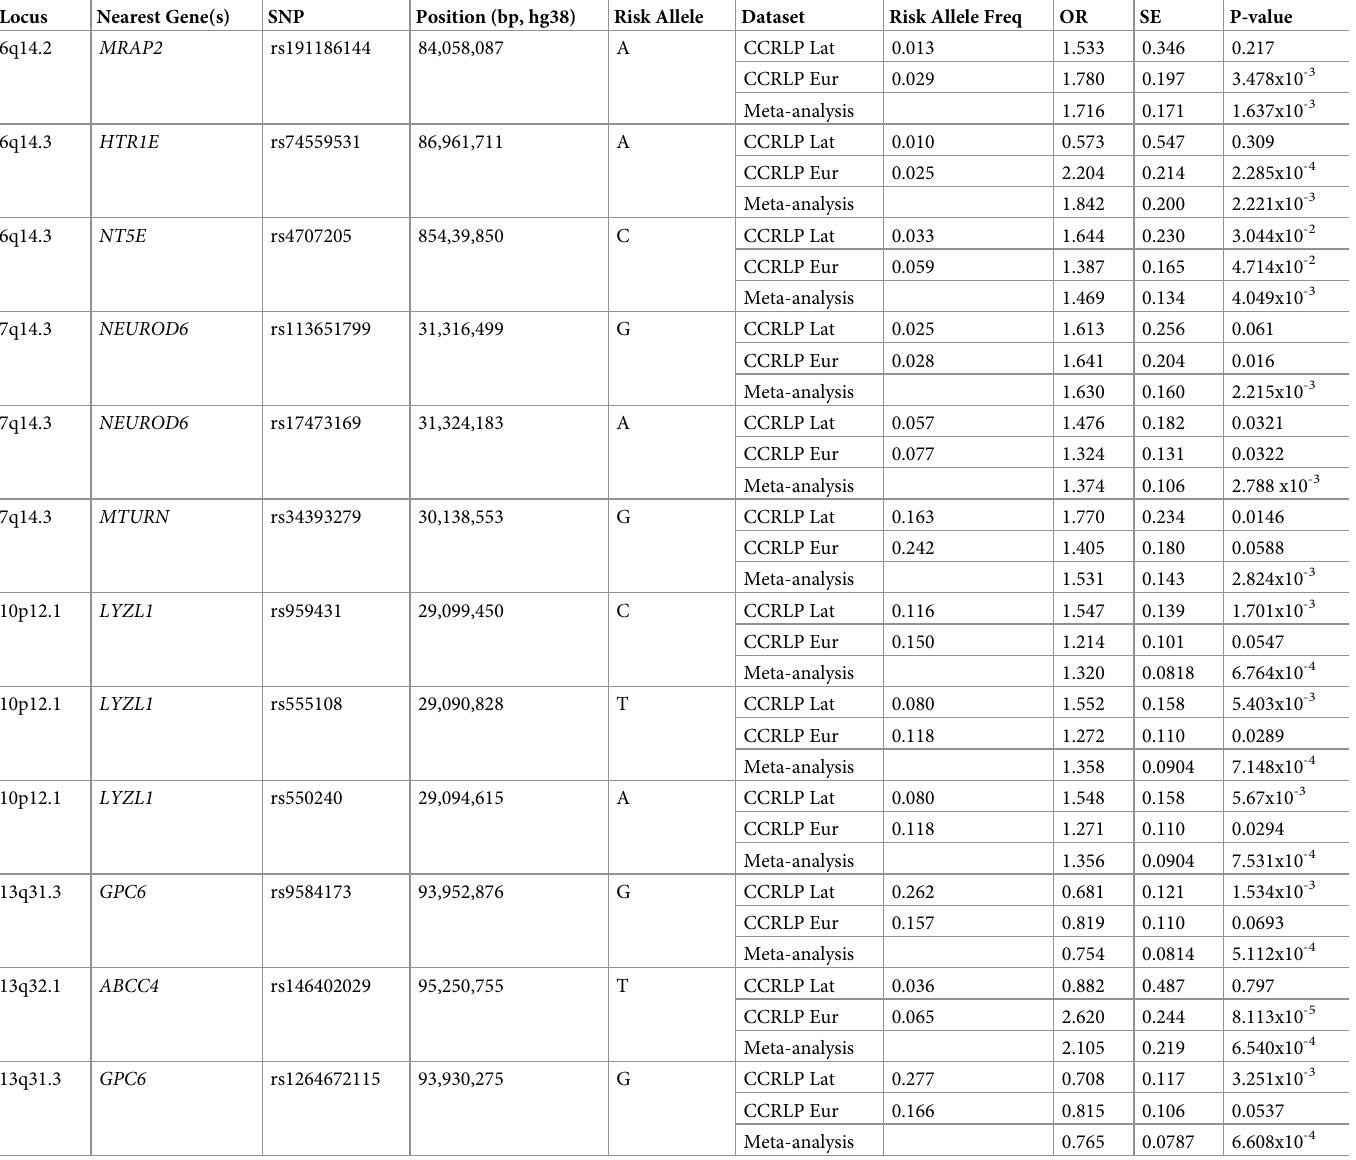
Table 1. Top SNPs from fine mapping analyses of admixture mapping